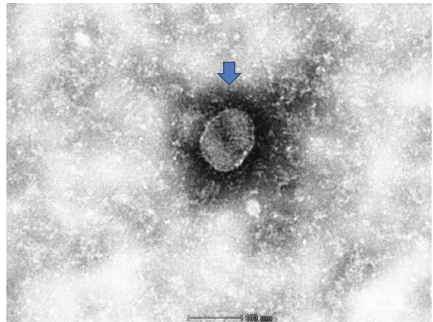
Figure 3: Negative staining electron microscopy showing the morphological appearance of the isolated virus. Note: presence of spike projections surrounding the viral particle (arrow) whose diameter ranges from 80 to 120nm. Mag × 100 𝜇